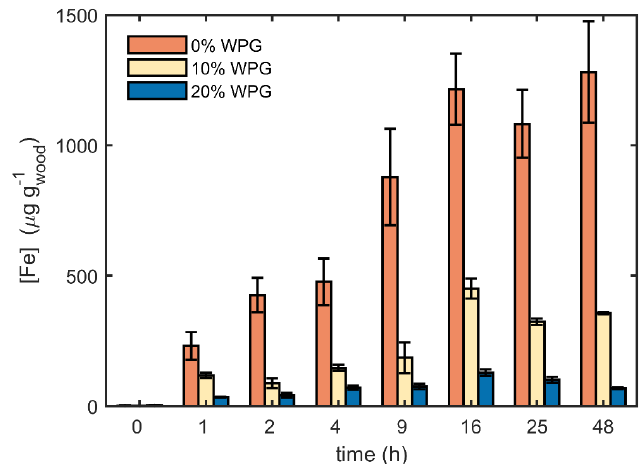
Figure 3. Concentration of iron in wood sections soaked in a 200 µM iron + 100 mM acetate solution as a function of the level of acetylation and time in solution. Error bars represent the 95% confidence interval.